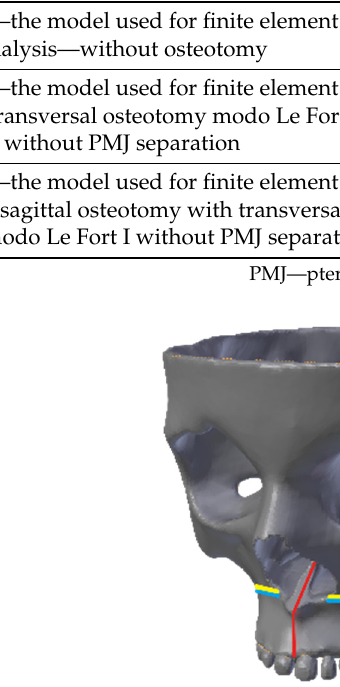
Table 2. A detailed course of modelled osteotomies and the order of the maps of stresses reduced according to Huber presented in the figures.